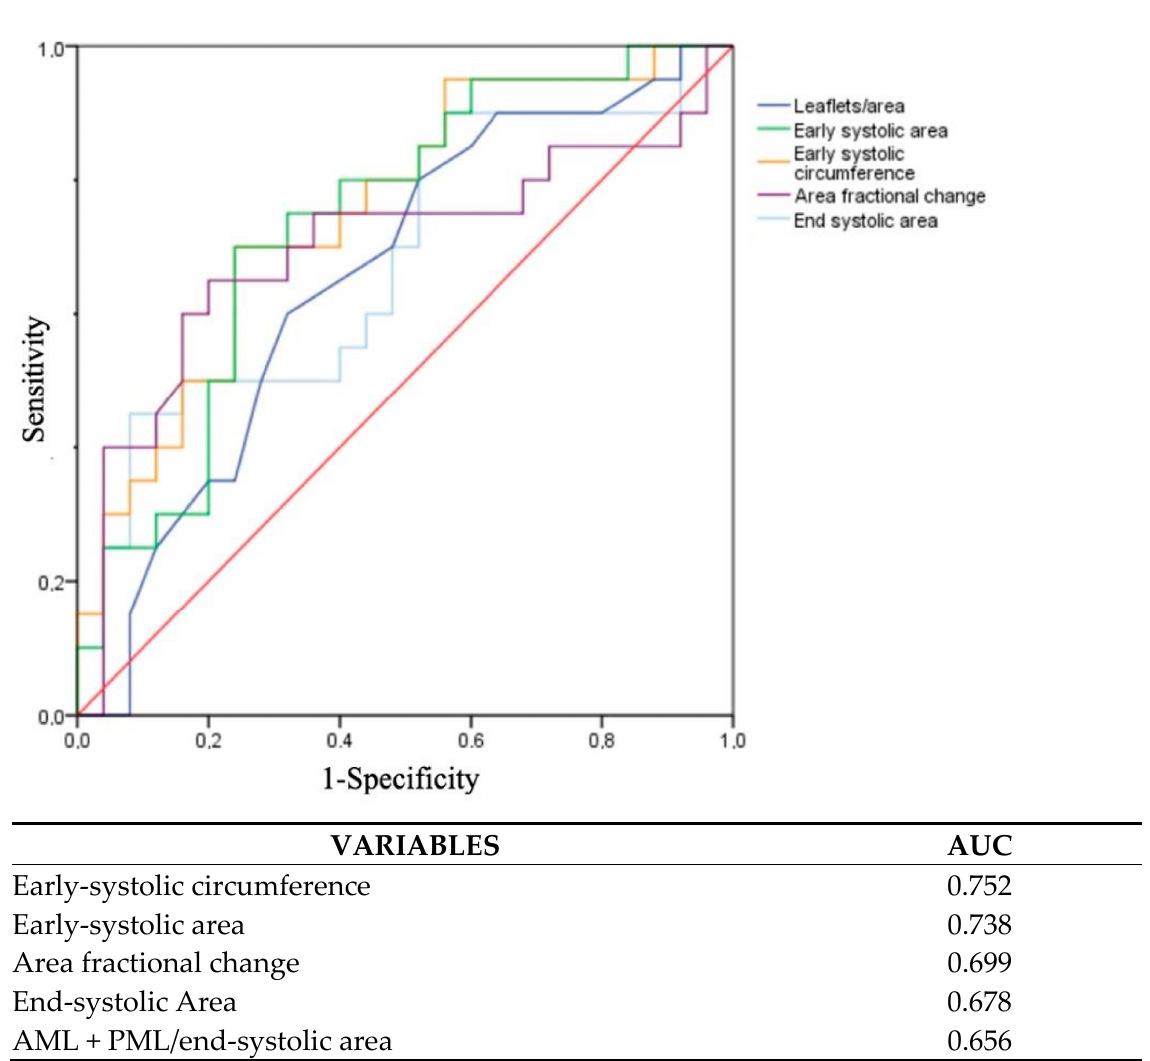
Figure 2. ROC and AUC of variables with best predictive values for moderate or less mitral regurgitation at last follow-up. AML: anterior mitral leaflet; AUC: area under the curve; PML: posterior mitral leaflet. Red line in the graph: test neutrality line.